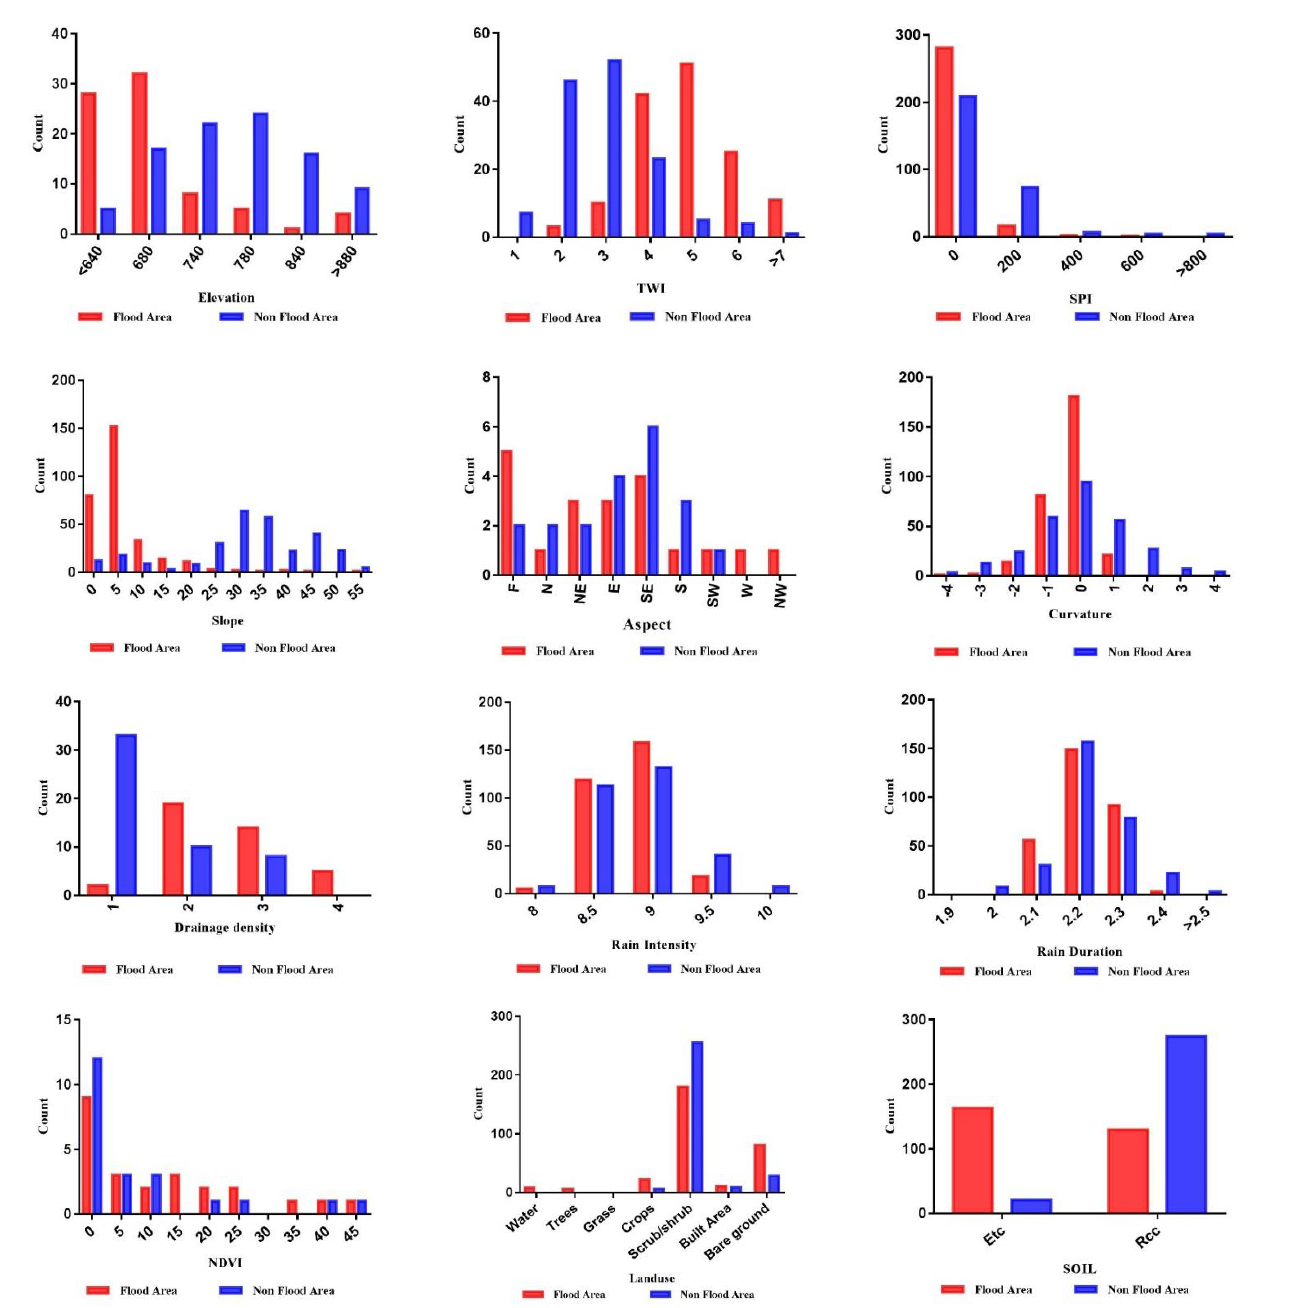
Figure 10. Factors distribution by flood occurrences.